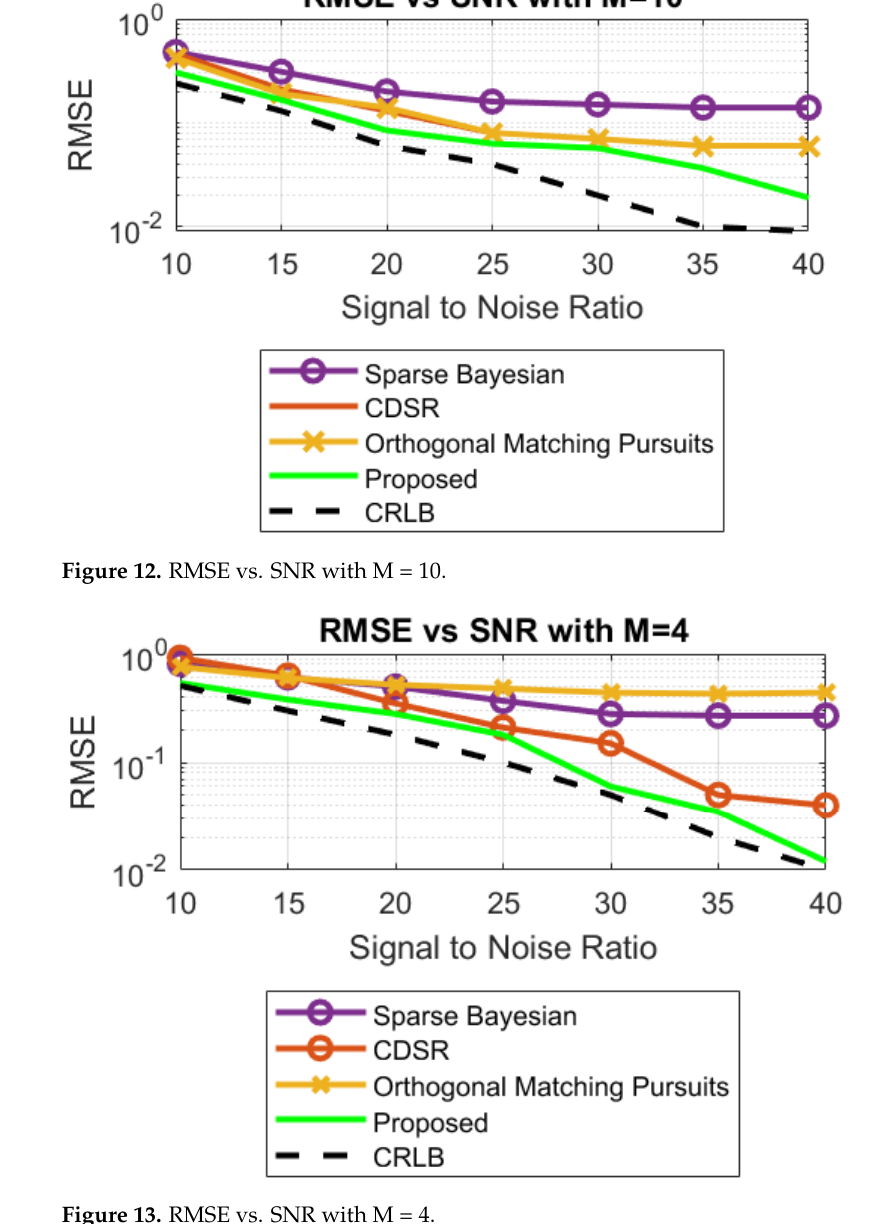
Figure 13. RMSE vs. SNR with M =